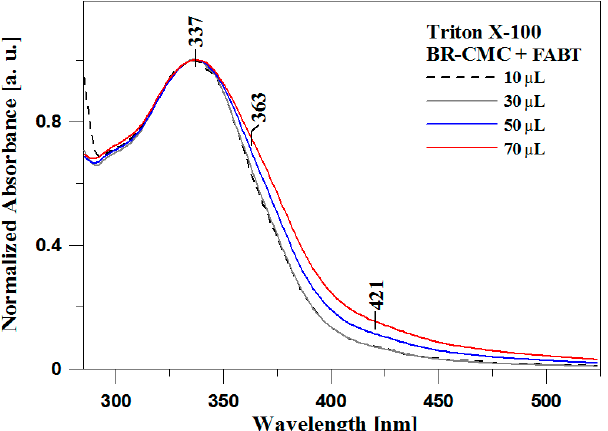
Figure 2. Normalized electronic absorption spectra for various amounts of FABT added in MeOH to the system with Triton X-100 detergent in the amount of 10 μ L (BR-CMC) per 3 mL of the buffer. The measurements were performed at the temperature of 22 °C.